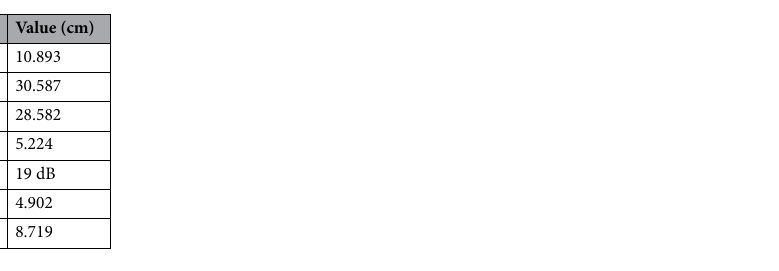
Table 2. Conical horn antenna design